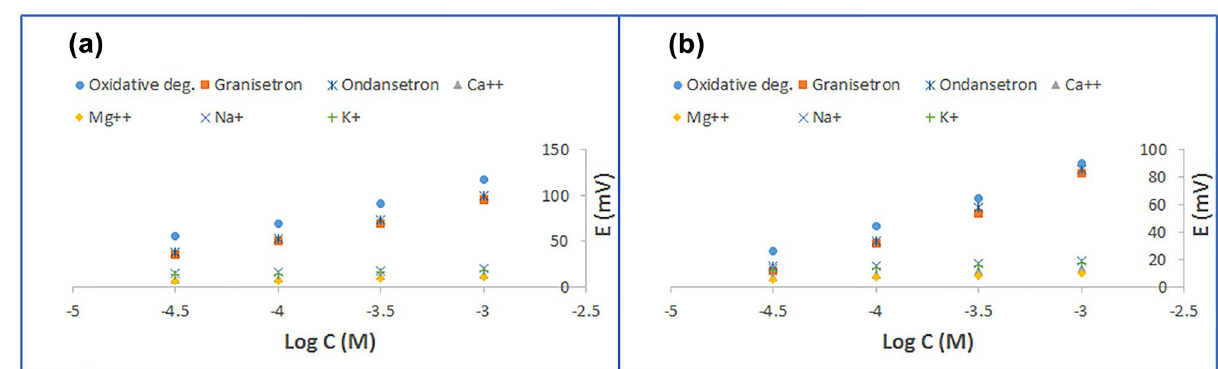
Figure 4. The responses of ( a ) ionophore-free sensor and ( b ) ionophore-doped sensor as function of log concentration for some inorganic ions, PALO oxidative degradation products and PALO structurally related drugs (granisetron & ondansetron) in selectivity measurements.